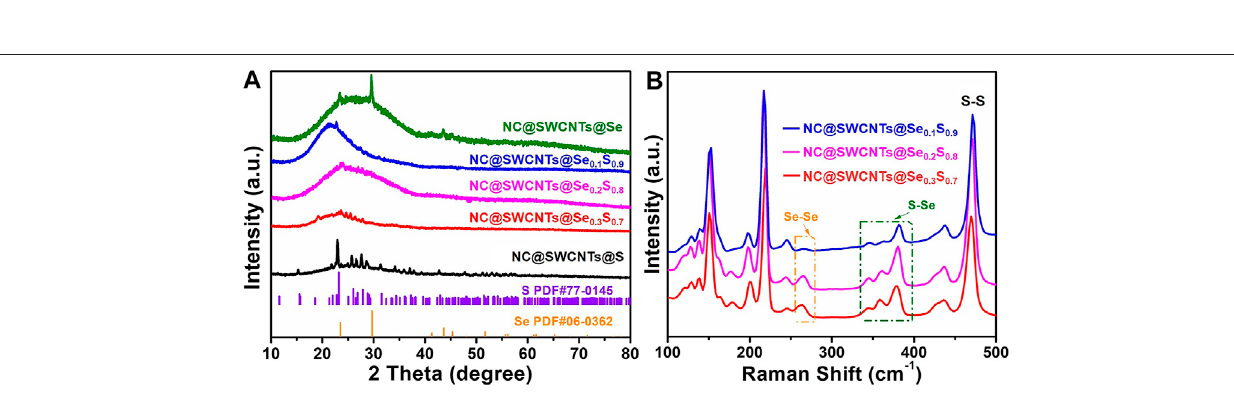
Frontiers in Chemistry |